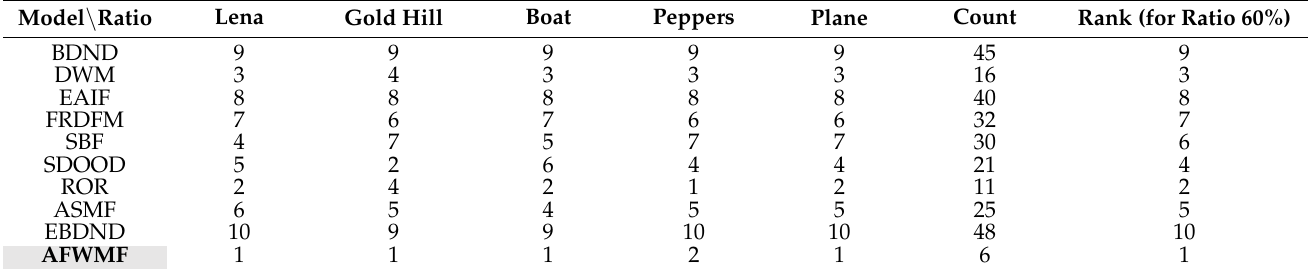
Figure 17. Repair map with a 60% random value of impulse noise for the Plane image. Table 6. The ranking of the 10 filter models according to the three experts’ average evaluations at 60% noise density for the five experimental images.